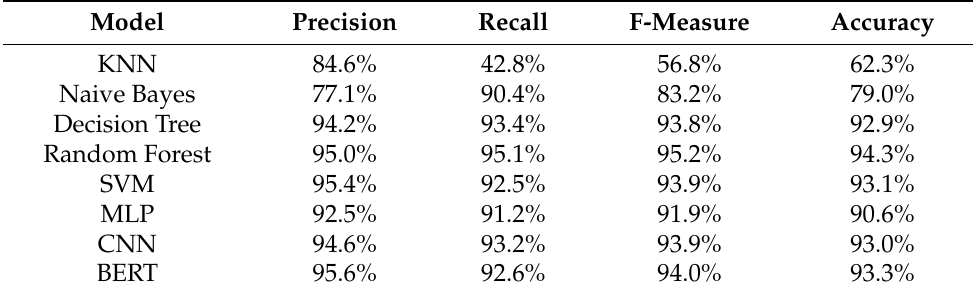
Table 3. Metric result of each model. Model Precision Recall F-Measure Accuracy